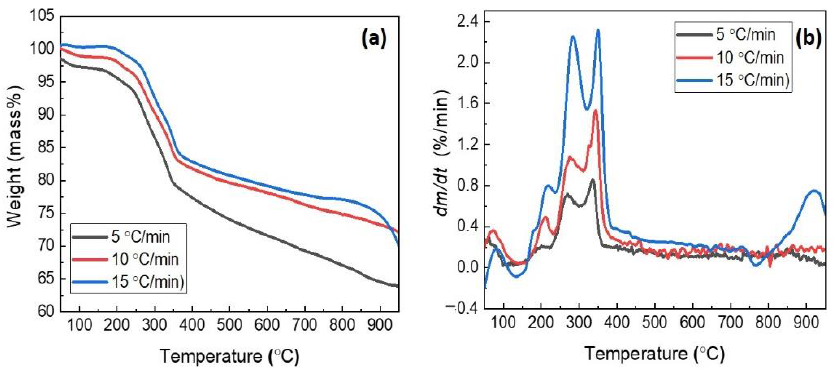
Figure 6. Thermogravimetric analysis: ( a ) weight percentage; ( b ) reactivity rate curves of composite pellet at a different heating rate.